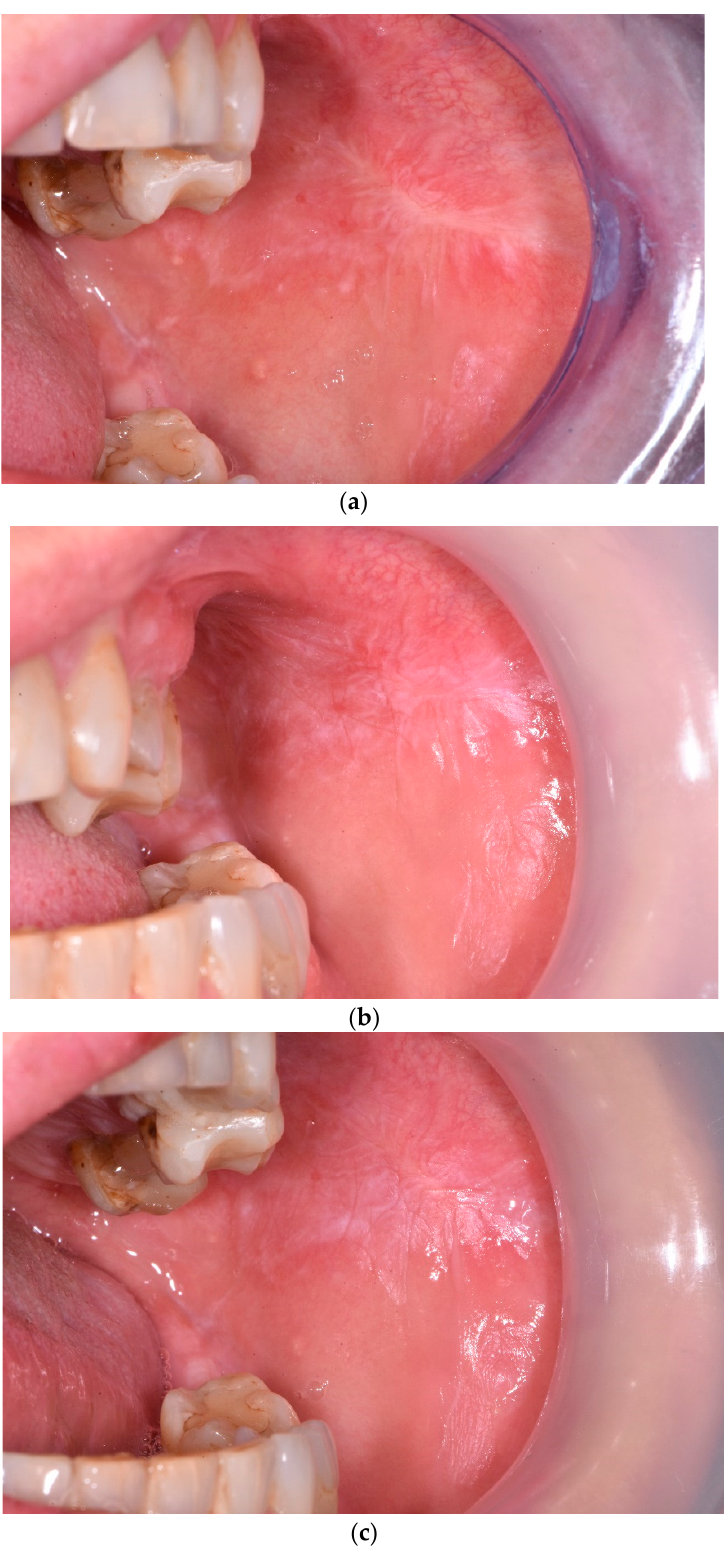
Figure 2. ( a ) Female patient, aged 44, before PDT. OLP on the left cheek. Size of the lesion—1.8 cm × 1.0 cm; surface area—1.8 cm 2 . ( b ) After PDT—lack of response to treatment. ( c ) One year later—extent of lesion area: 2.5 cm × 1.0 cm; surface area: 2.5 cm 2 .